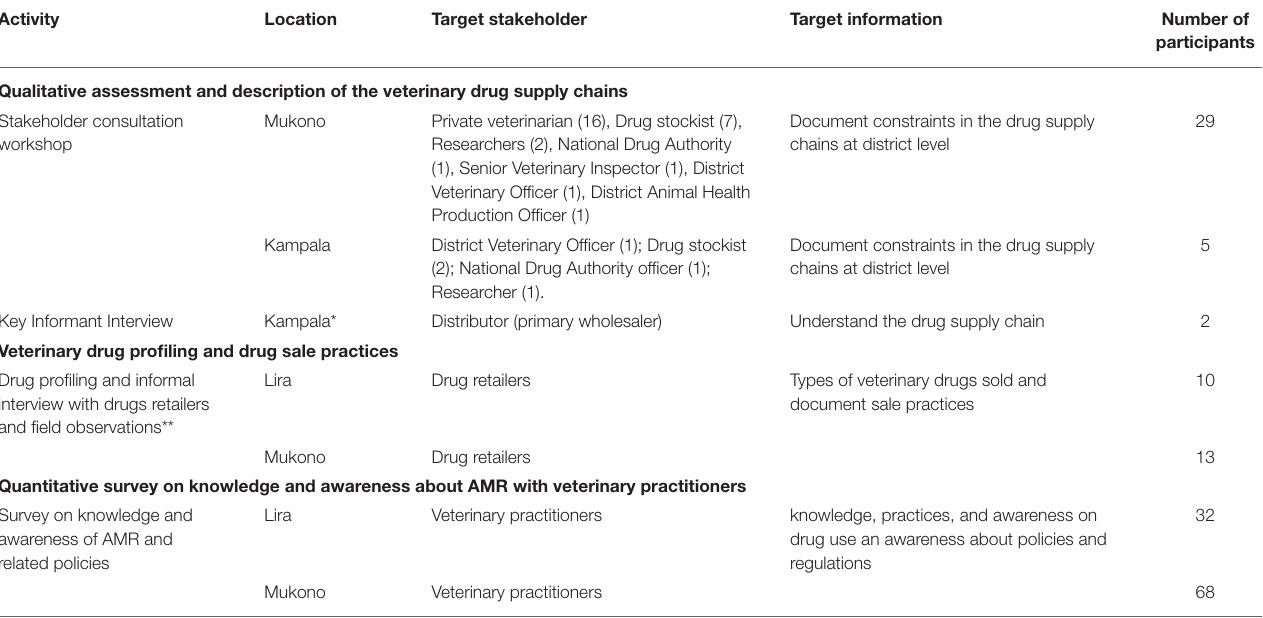
TABLE 1 | Profile of participants to different